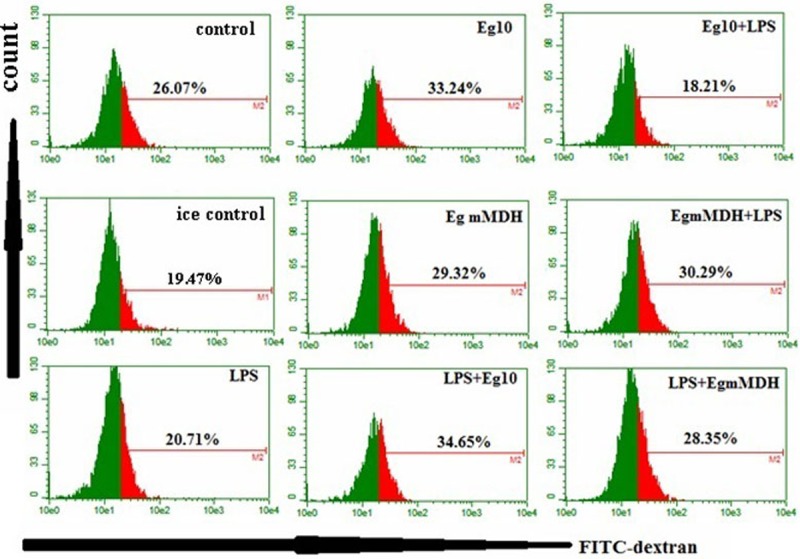
Phagocytic abilities of DCs exposed to antigens.BMDCs of each treatment group in experiment (1) were collected, and FITC-dextran (40 kDa) was added a final concentration of 1 mg/ml. The mixture was incubated at 37°C or at 4°C (for control binding)for 1 h and detected by flow cytometry. The uptake ability of DCs was measured by the intensity of fluorescence of FITC. Red shows the intensity of FITC of cells uptake FITC-dextran. Green shows the intensity of cell background. Each sample was analyzed in triplicate, and data were collected for 10,000 cells. Control means DCs are in RPMI1640 culture medium. Ice control is RPMI1640 culture medium treated at 4°C.